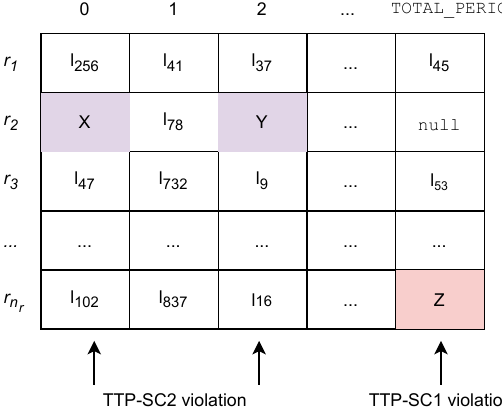
Figure 7. Example of soft constraints in a